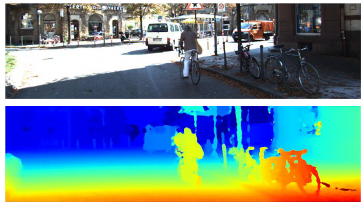
Figure 14. The qualitative results from [33] show the left RGB image from a scene in the KITTI depth completion dataset in the top row and the corresponding depth map prediction in the bottom row are shown using colour to represent the depth values.